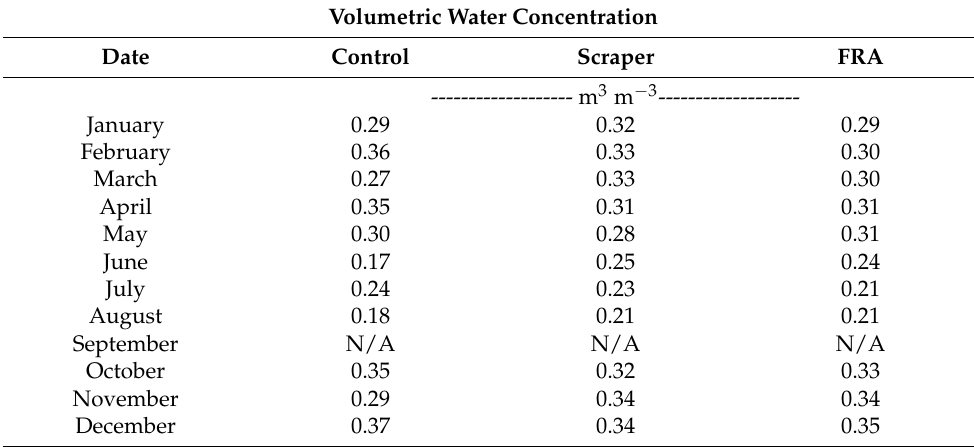
Table 2. Volumetric water concentration means by month in 2018 per treatment taken in conjunction with pressure chamber measurements.